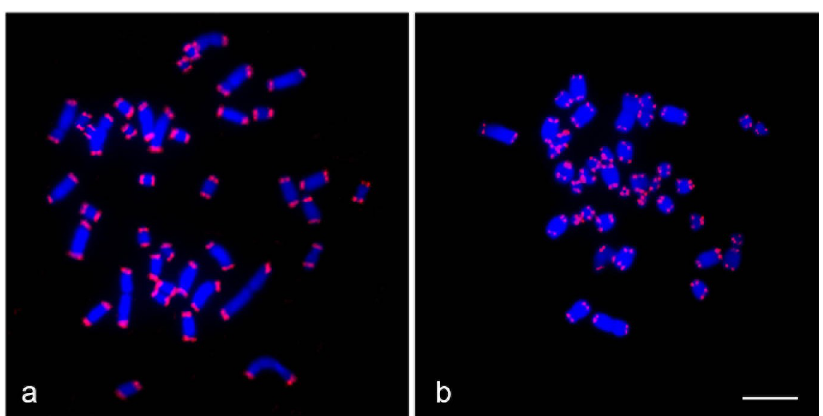
Fig 3. Chromosomal locations of (CCCTAA)n sequences in Hemidactylus frenatus . Hybridisation pattern of Cy3-labelled CCCTAA repeats (red) in male H . frenatus (a), female H . frenatus (b). Scale bar represents 10 μ m.